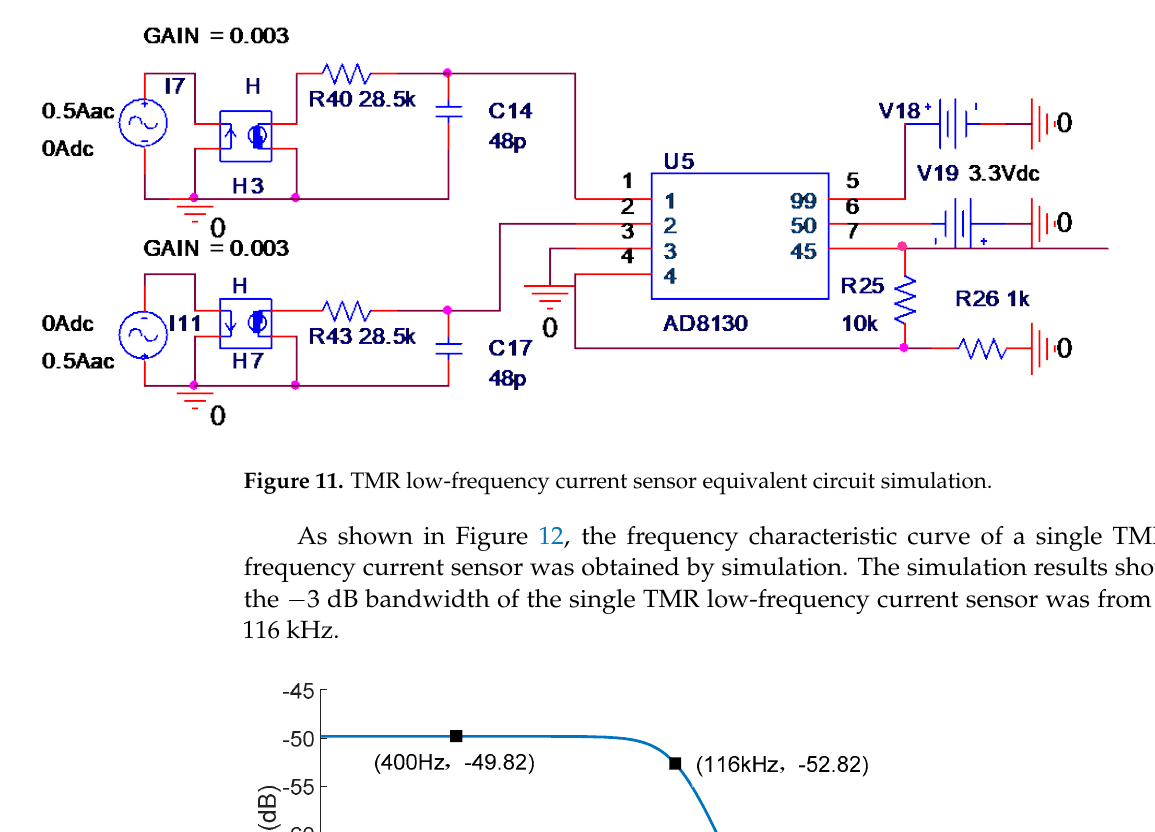
Figure 11. TMR low-frequency current sensor equivalent circuit simulation.